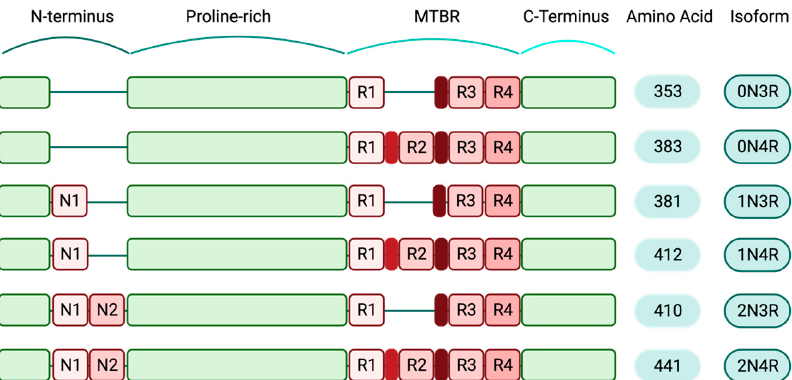
Figure 1. Human-specific tau isoforms (created with BioRender.com). Schematic diagram depicting the composition of different tau isoforms. The shortest tau variant, which is mainly expressed during the human embryonic stage, consists of 352 amino acids (0N3R) and the full-length isoform (2N4R) includes all structural domains of tau protein and 441 amino acids. Structurally, tau isoforms are comprised of N-terminus regions that contain two inserts, N1 and N2. The au N-terminals are followed by the proline-rich domains, the microtubule-binding regions (MTBR) and the C-terminals. In the full-length tau isoform, all four repeat domains (R1–4) are present in the MTBRs.